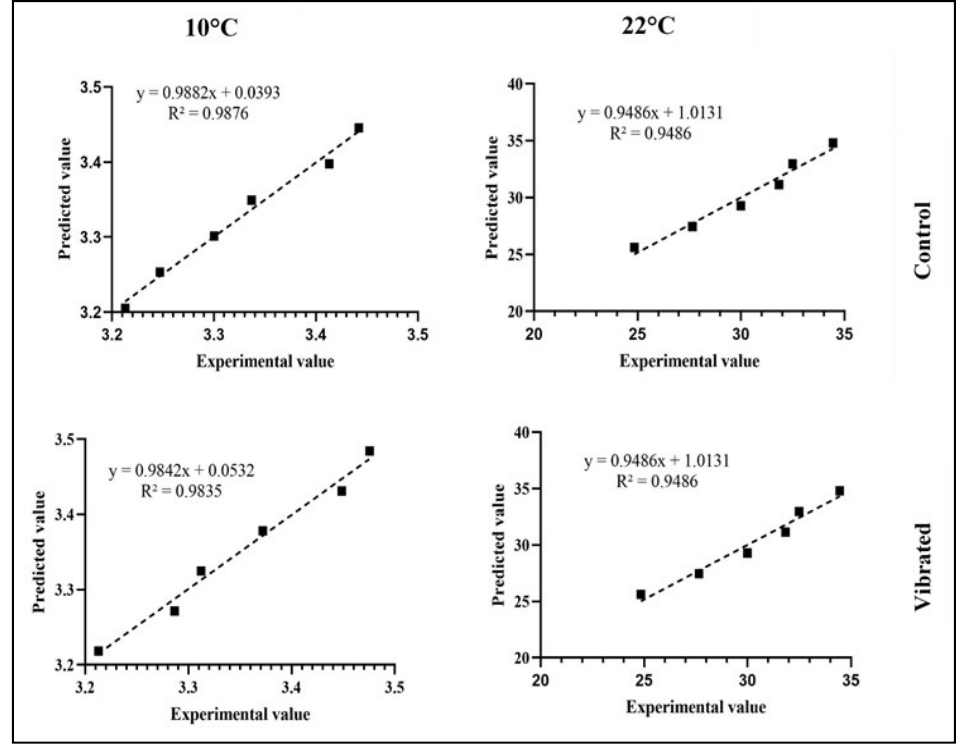
Figure 6. Predicted and experimental results of a* change kinetic of vibrated and non-vibrated (control) tomatoes stored at 10 °C and 22 °C .